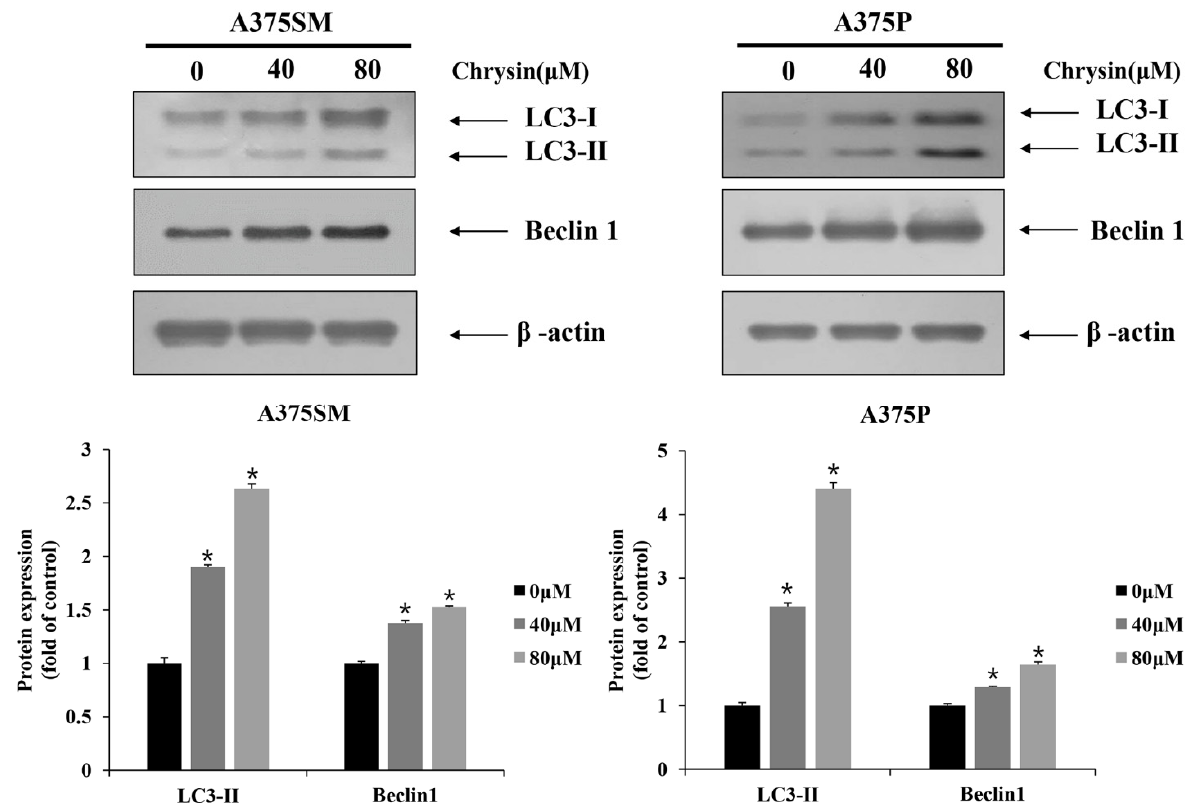
Figure 6. Chrysin induces autophagy proteins in A375SM and A375P human melanoma cancer cells. Cells were treated with the indicated concentrations of chrysin and protein levels of LC3 and Beclin 1 were measured by Western blotting. β -actin was used as a loading control. Quantification was performed in three independent experiments using ImageJ, normalizing the intensities of the bands to the controls. Data are presented as the mean and standard deviation for three samples. Significance was determined by Student’s t -test, * p < 0.05, compared with the control.